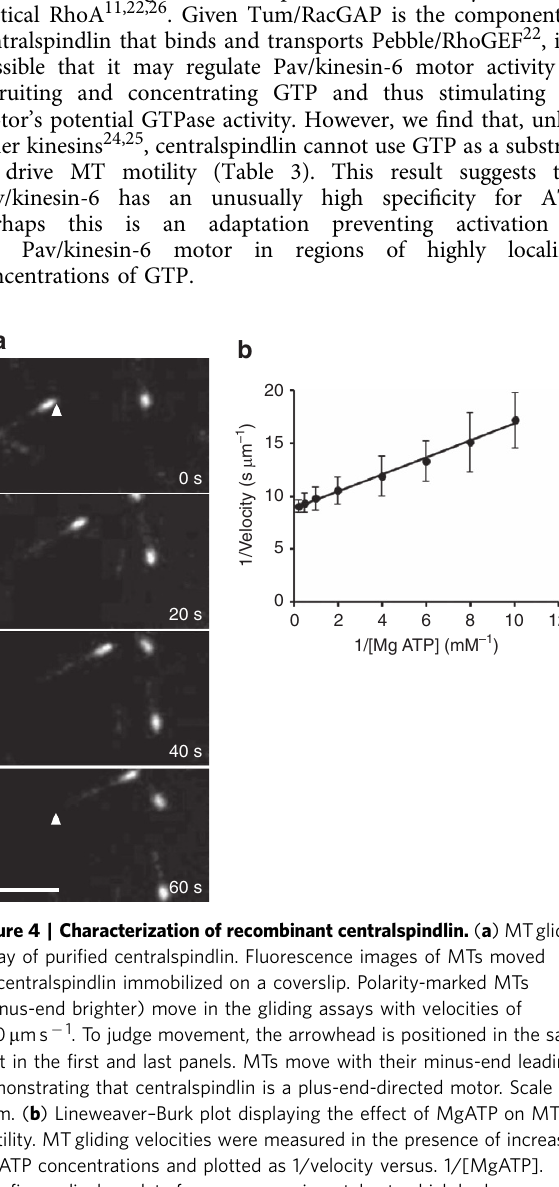
Table 2 | Summary of gliding assays under different motor conditions.